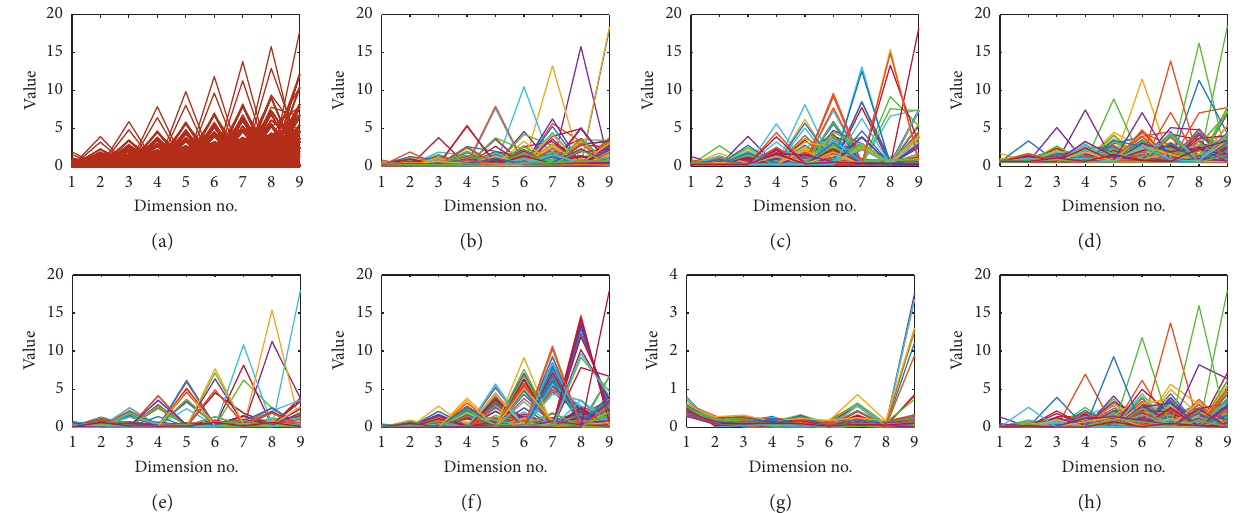
Figure 4: For 9-objective MaF10, its true PF and output populations of seven algorithms in parallel coordinate: (a) true PF of MaF10; (b) RVEA on MaF10; (c) NSGA-III on MaF10; (d) VaEA on MaF10; (e) MOEA/DD on MaF10; (f) SPEA2+SDE on MaF10; (g) MOEA/D- AM2M on MaF10; (h) ASES on